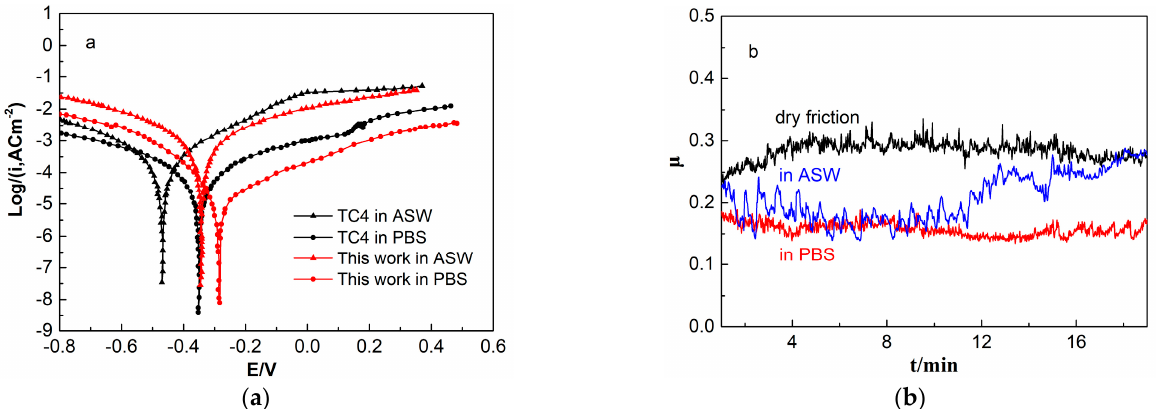
Figure 4. ( a ) Potentiodynamic polarization curves of Ti–6Al–4V and Ti 40 Ni 40 Cu 20 BMGC in ASW at 298 K and PBS at 310 K; ( b ) friction coefficient of Ti 40 Ni 40 Cu 20 /GCr15 under dry friction and in ASW, PBS solutions.